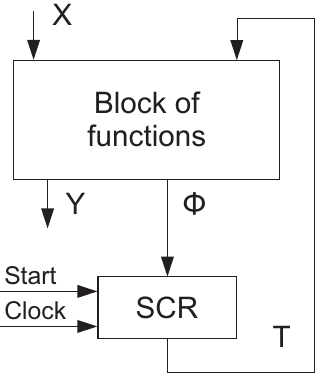
Figure 1. Structural diagram of P Mealy FSM.